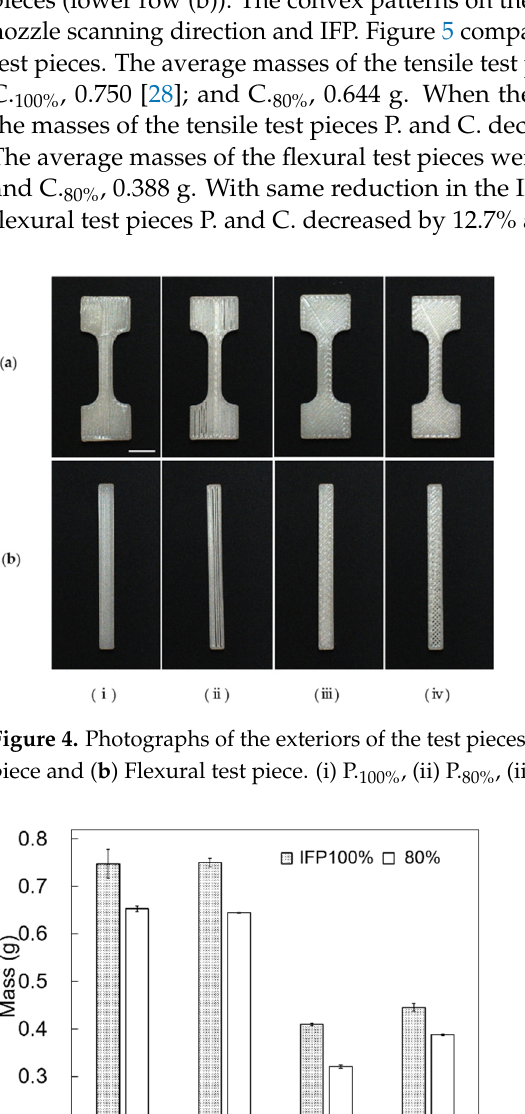
Figure 5. Comparison of the masses of the non-immersed test pieces. Average ± S.D., N = 5.